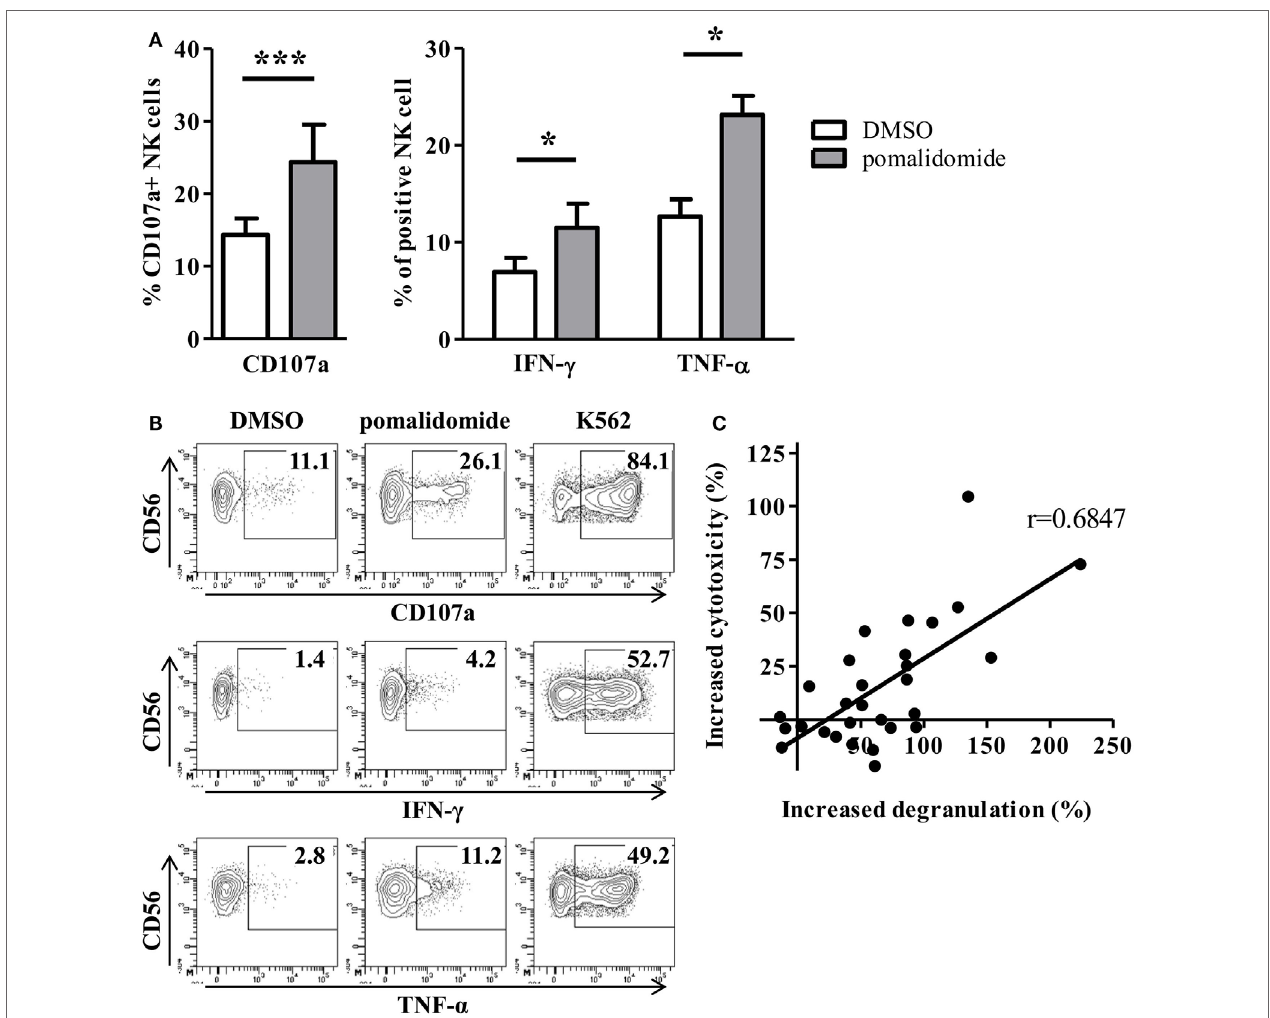
FigUre 3 | Pomalidomide pretreatment of leukemia cells markedly enhances natural killer (NK) cell functions. After 48 h incubation of primary acute myeloid leukemia (AML) blasts with pomalidomide or DMSO, the cells were extensively washed before the co-culture with NK cells from healthy volunteers (HV) for 4 h. NK cell functions were assessed by flow cytometry. (a,B) Percentage of HV-NK cells degranulating (CD107a + ), and IFN- γ and TNF- α production, was monitored using cytometry. K562 cell line was used as a positive control. (a) Data obtained from NK cells ( n = 1–5) in response to 12 primary AML blasts treated by pomalidomide or DMSO are presented. Results were expressed as mean ± SEM and statistical significance was established using Wilcoxon matched pairs test. (B) Representative dot plot from one experiment. (c) Linear correlation of the AML blasts ( n = 12) sensitivity to pomalidomide (increased cytotoxicity by allogeneic NK cells due to AML pomalidomide treatment) and the NK cell degranulation (increased degranulation) ( n = 1–5) correlation was established using Pearson’s correlation